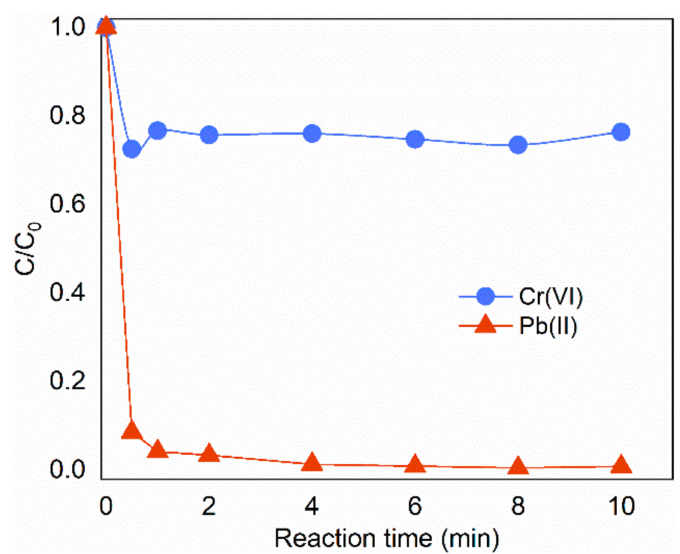
Figure A1. Removal e ffi ciency of Cr(VI) and Pb(II) by in-situ formed MnO 2 . Conditions: [Cr(VI)] 0 = 353.5 µ g L − 1 , [Pb(II)] 0 = 625.5 µ g L − 1 , and [MnO 2 ] 0 = 10.0 mg L − 1